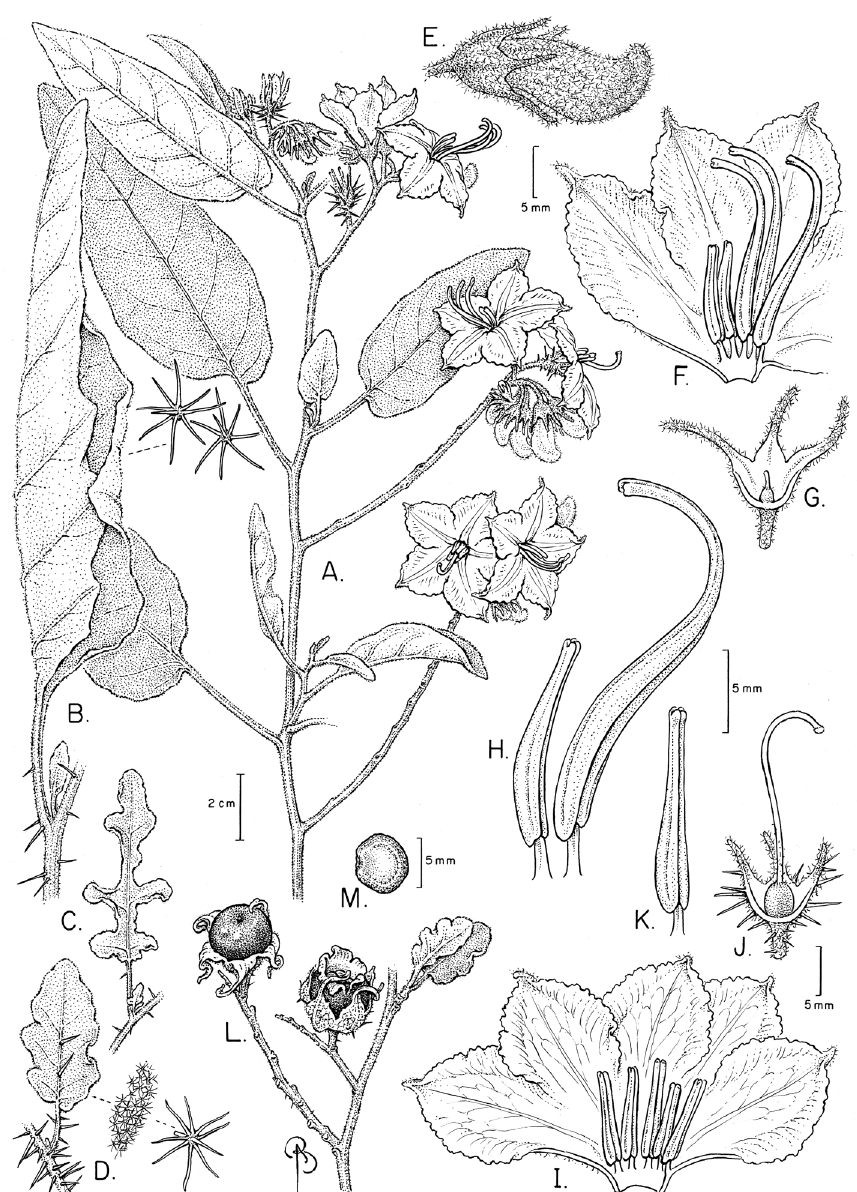
Figure 10. Solanum houstonii Martyn. A Whole plant B Leaf with prickly petiole and stellate tri- chomes C Lobed leaf D Prickly stem with stellate trichomes E Bud F Staminate flower G Ovary and style of staminate flower H Anthers of staminate flower I Hermaphroditic flower spread J Gynoecium of hermaphroditic flower K Anther of hermaphroditic flower L Fruits M Seed. Drawn by Bobbi Angell A, E from Fryxell 3706 (NY00751643) B from Durán et al. 4737 (NY00751647) C from Reina G.